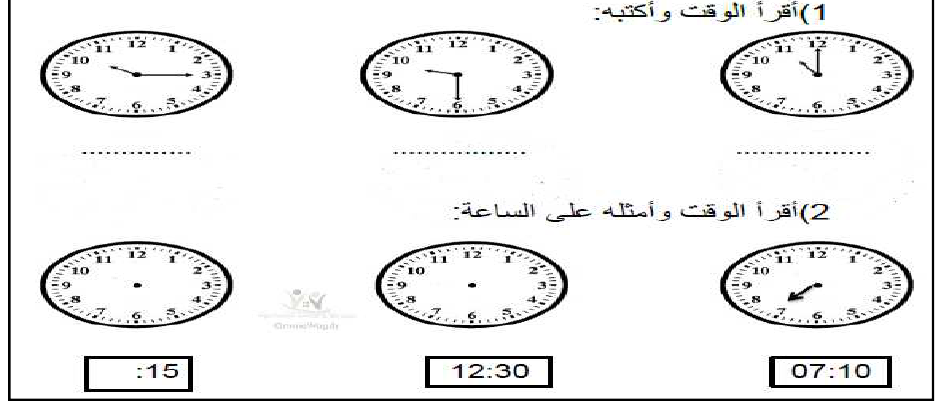
Fig. 3. Les consigne du test pour évaluer la notion « mesure du temps» .